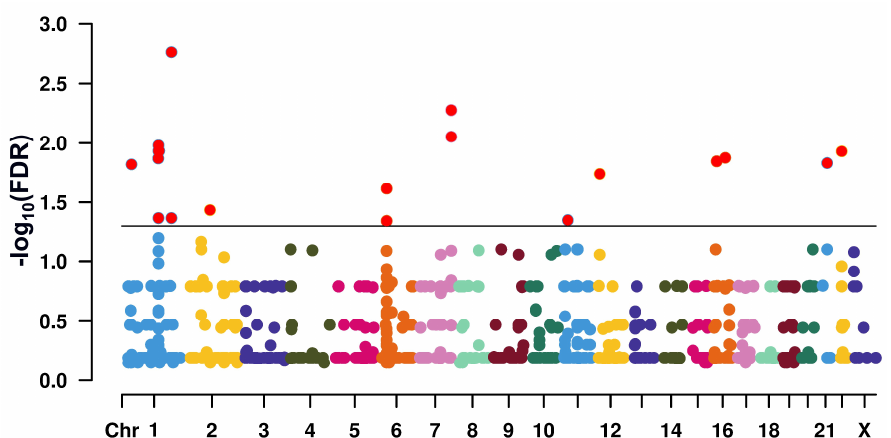
Figure 2. Manhattan plot giving the genomic position of single-nucleotide polymorphisms (SNPs) with differing allele frequencies between normal-fertile and infertile men. Only SNPs (N = 840) which had been genotyped in all 100 probands were considered. The Y-axis refers to —log10-transformed false discovery rates (FDRs). The horizontal line at 1.3 corresponds to the 5% significance threshold. SNPs exceeding the threshold are highlighted in red. Coloration of the remainder SNPs reflects their localization on different chromosomes. For clarity, chromosome (Chr) numbering is incomplete.